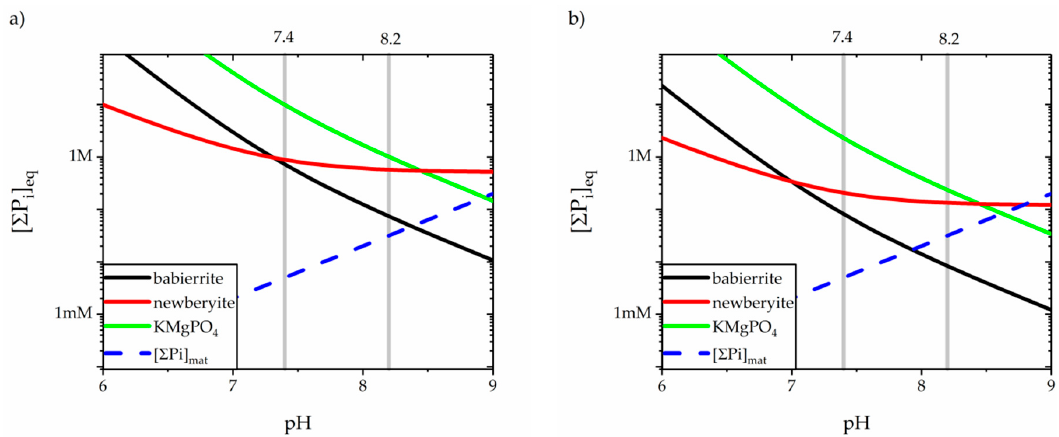
(cid:80) Figure 5. The calculated equilibrium concentrations [ P i ] eq required for the formation of magnesium Figure 5. The calculated equilibrium concentrations [ ∑ P i ] eq required for the formation of magnesium phosphates as functions of pH. Magnesium concentration set to ( a ) [Mg 2 + ] = 0.35 mM and phosphates as functions of pH. Magnesium concentration set to ( a ) [Mg 2+ ] = 0.35 mM and ( b ) [Mg 2+ ] = ( b ) [Mg 2 + ] = 1.5 1.5 mM.